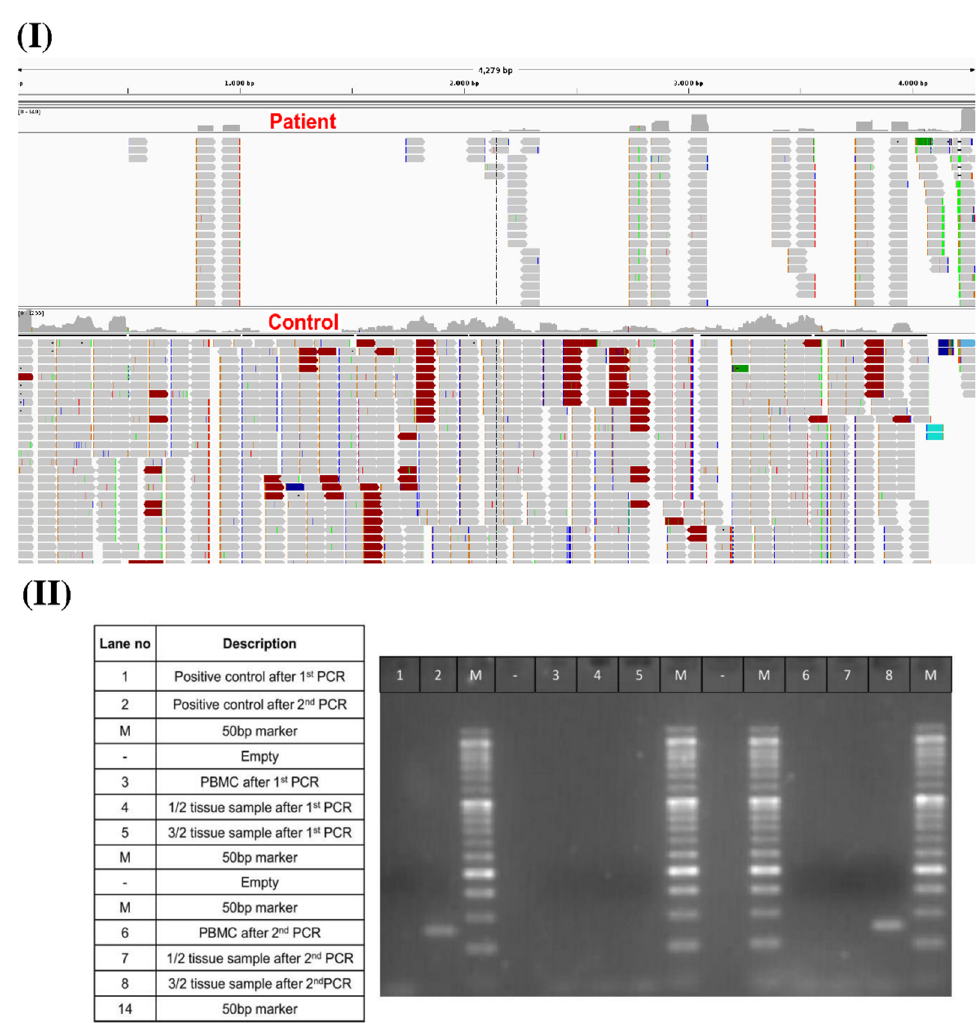
Figure 3. ( I ) Distribution of mapped RNA-seq reads across spike mRNA. ( II ) PCR validation of vaccine spike mRNA expression in the patient’s muscle tissue biopsy samples one-month post-vac- cination.